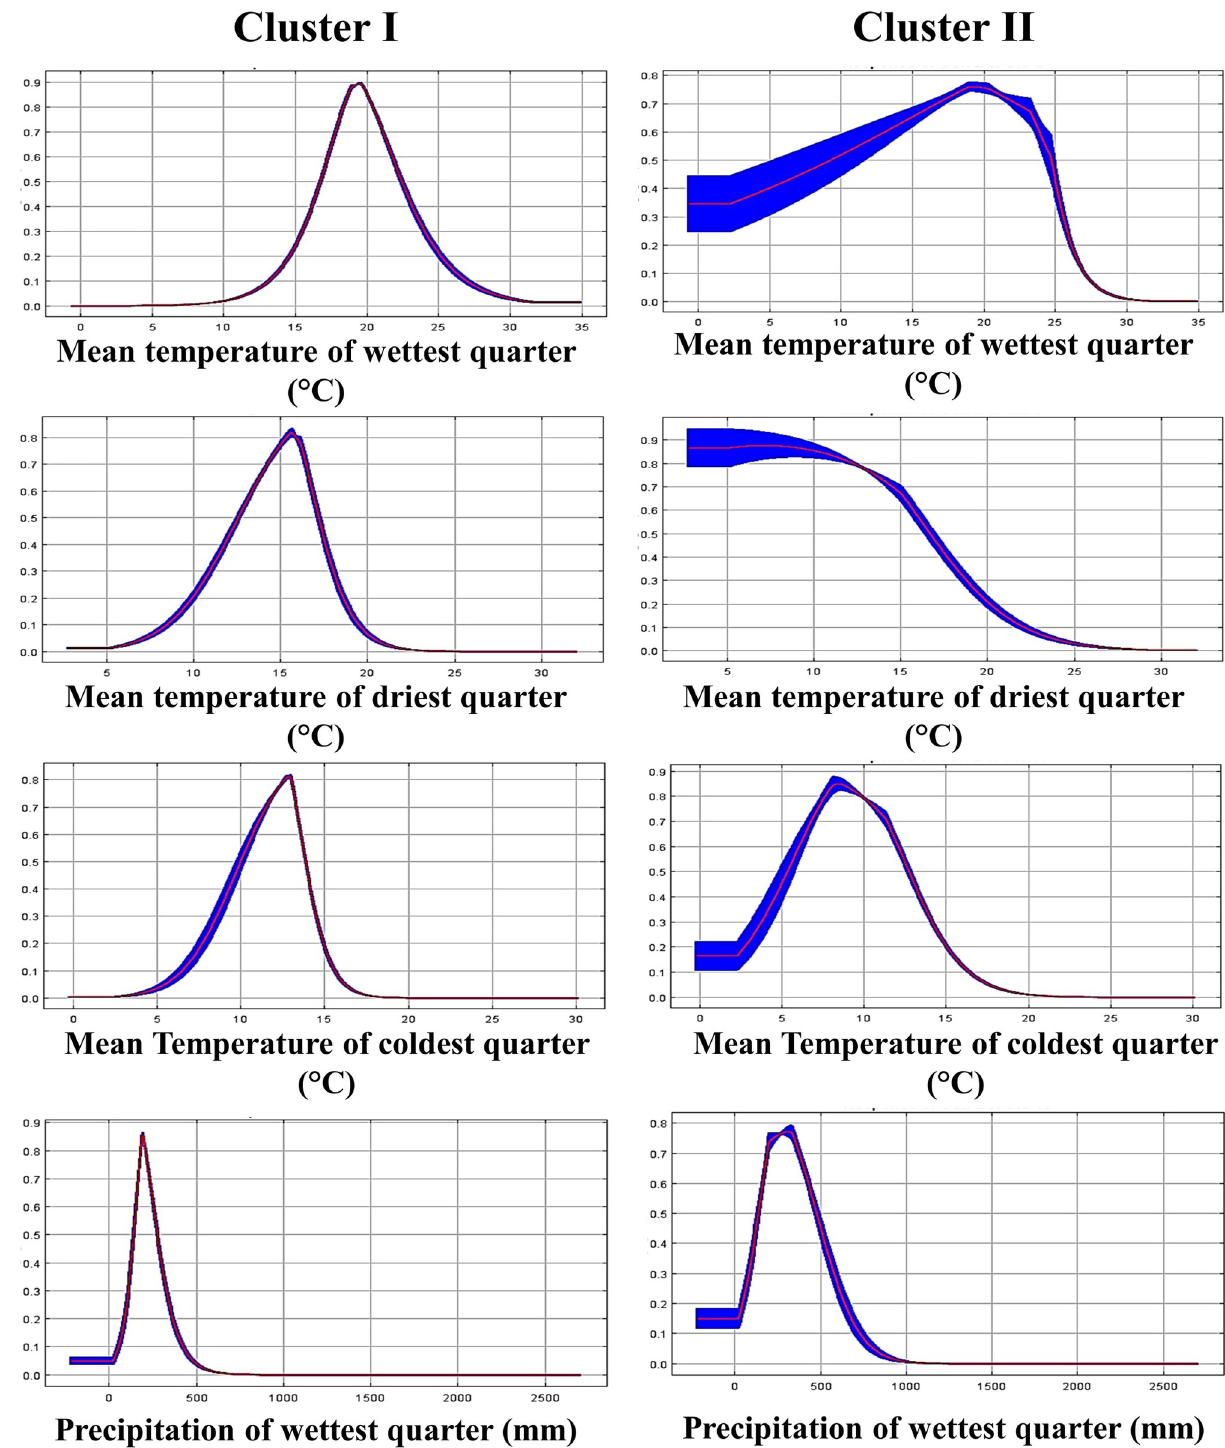
Fig 7. Response curves of the greatest contribution variables for the enviromental niche models of two genetic cluster of sideoats grama ( Bouteloua curtipendula ).